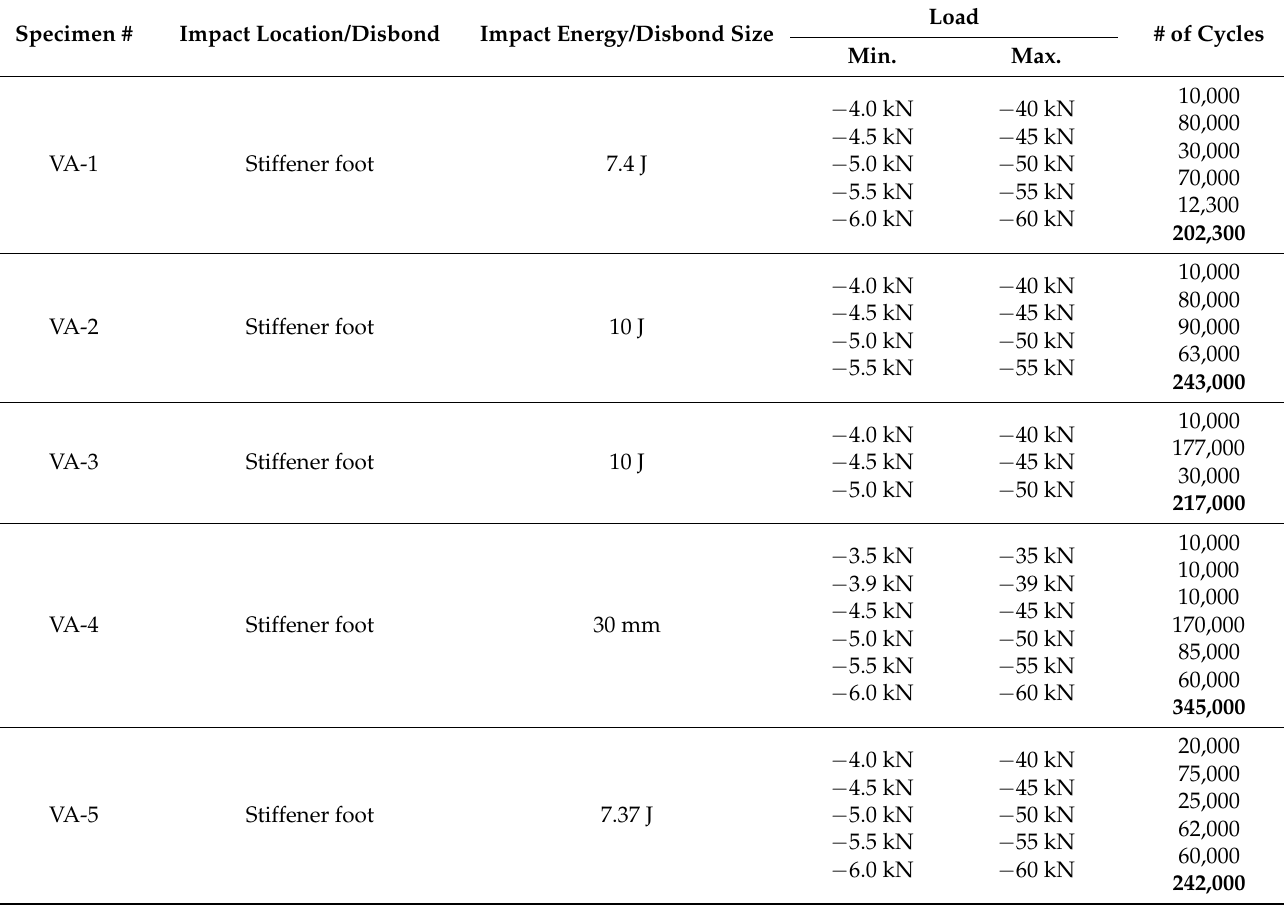
Table 2. Variable amplitude fatigue test campaign